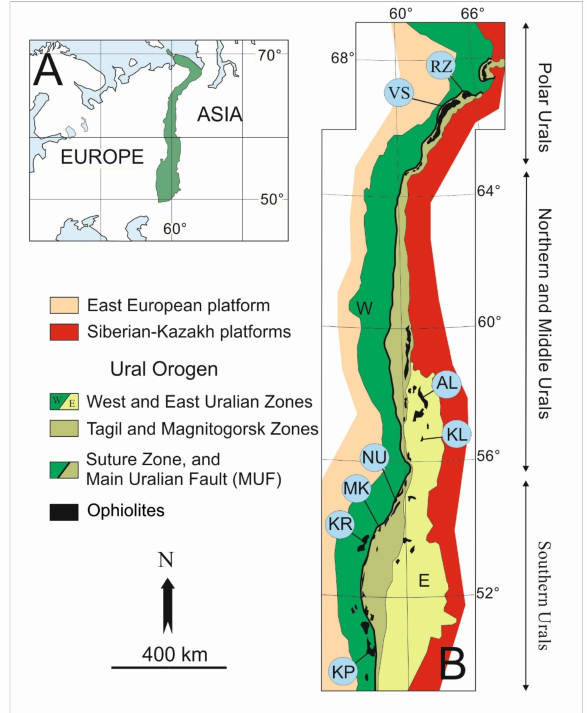
Figure 1. Geographic location of the Ural Orogenic Belt, marking the border between Europe and Asia ( A ). Schematic geological map of the Ural lithostratigraphic units, and distribution of the principal ophiolite complexes ( B ). From north to south: RZ = Ray-Iz, VS = Voykar Syninsky, AL = Alapaevsk, KL = Kluchevskoy, NU = Nurali, MK = Mindyak, KR = Kraka, KP = Kempirsai. Modified after